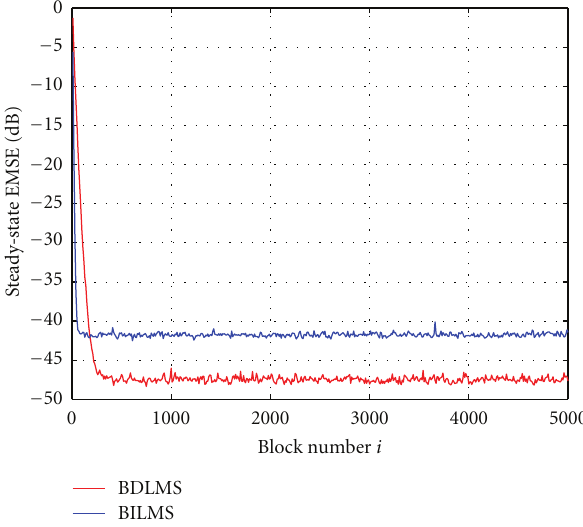
Figure 15: Global excess mean-square error curve for BILMS and